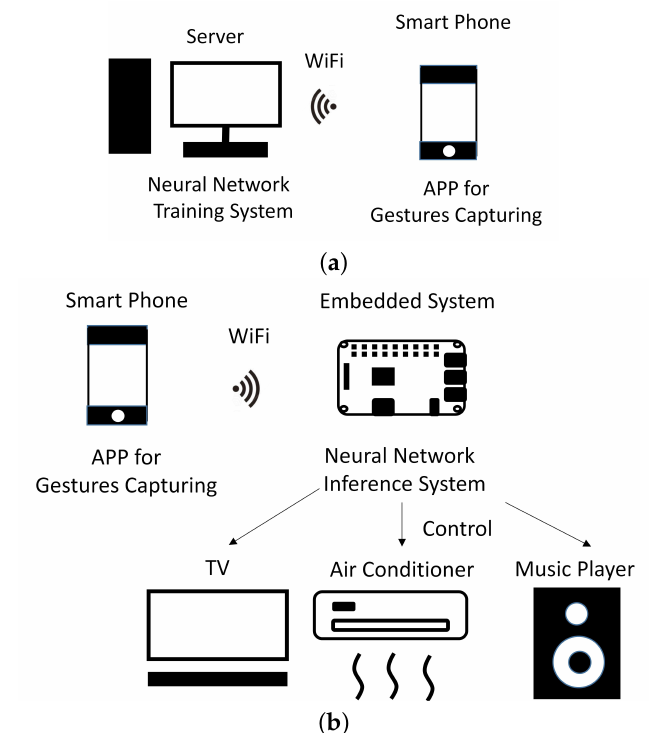
Figure 11. The proposed gesture-based remote control system for home appliances: ( a ) the training system for dynamic gesture recognition; ( b ) real-time gesture recognition system for the remote control of home